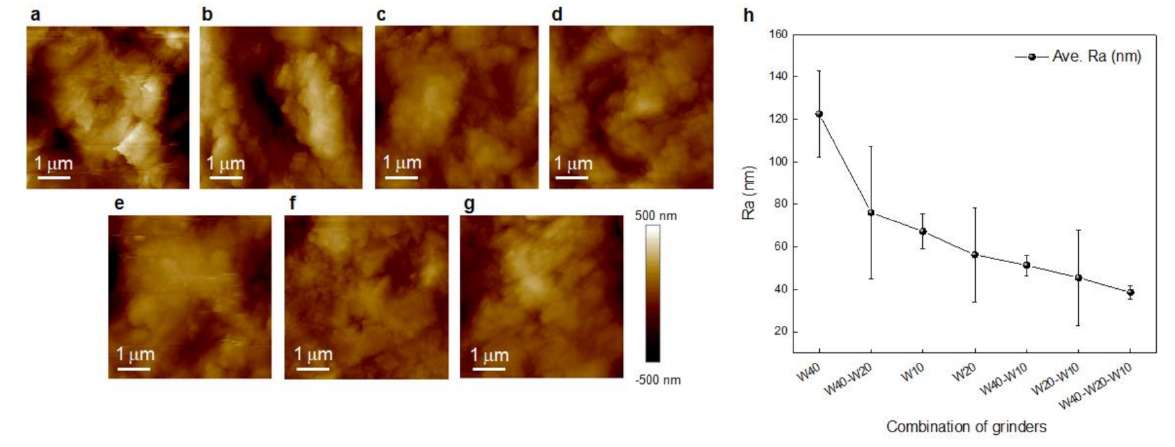
Figure 3. Corresponding AFM surface topography of diamond films ground by different combina- tions of abrasive particles (5 × 5 µ m 2 ). ( a ) W40; ( b ) W40 to W20; ( c ) W10; ( d ) W20; ( e ) W40 to W10; ( f ) W20 to W10; ( g ) W40 to W20 to W10. The value of ( a – g ) is 137, 112, 61.4, 58, 51.9, 46.8, 39 nm, respectively. ( h ) The evolution of the roughness gives a linear decrease with diameter of diamond particles in the